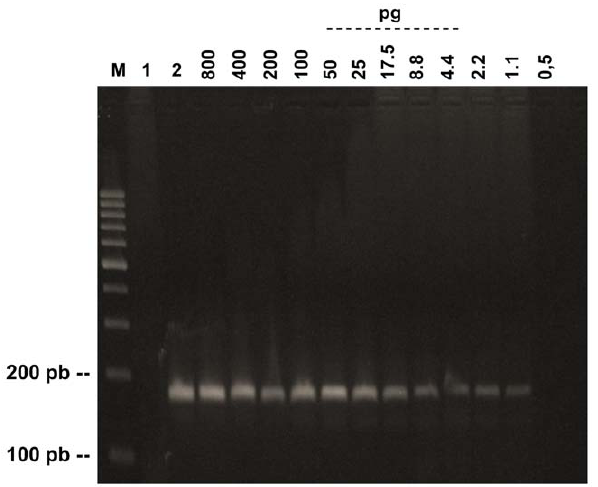
Figure 2. Detection limit of PCR assay with different amounts of DNA of P.lutzii . M, 100 bp DNA ladder; 1, negative control; 2,